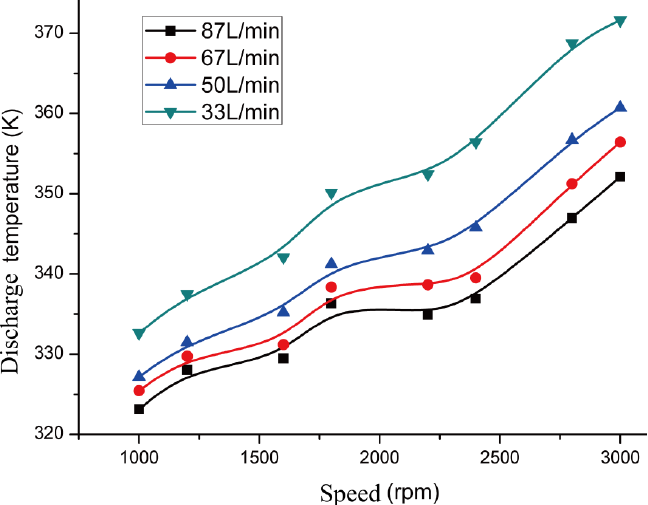
Figure 3. Variation of discharge temperature at different rotational speeds.